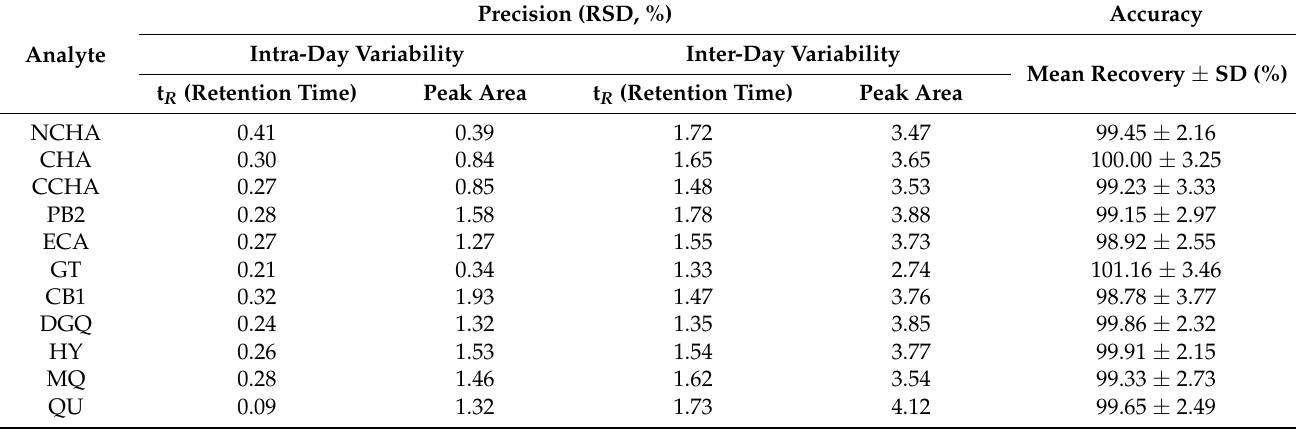
Table 5. Precision and accuracy data for the proposed HPLC-PDA